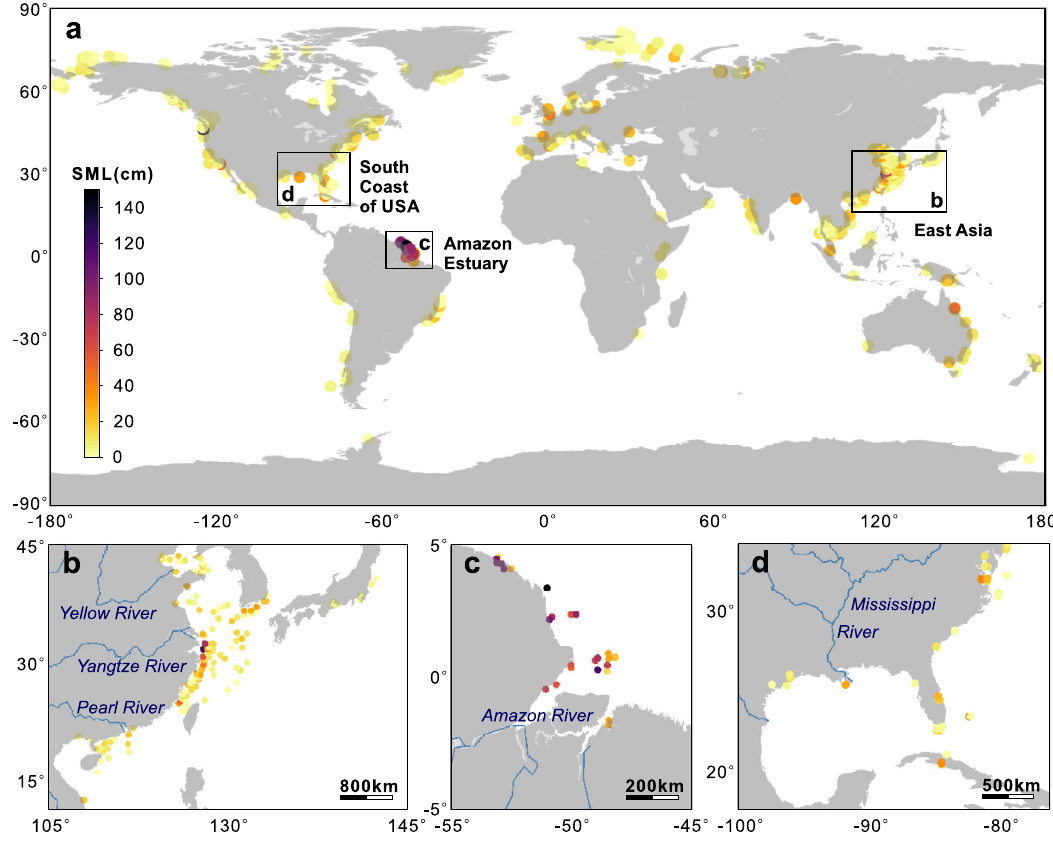
Fig. 2 | The thickness of the sediment mixed layer (SML) estimated by excess 210 Pb ( 210 Pb ex ) pro fi les. a The global coastal ocean with 742 sites; b The coastal ocean of East Asia; c The Amazon Estuary; and d Gulf of Mexico.